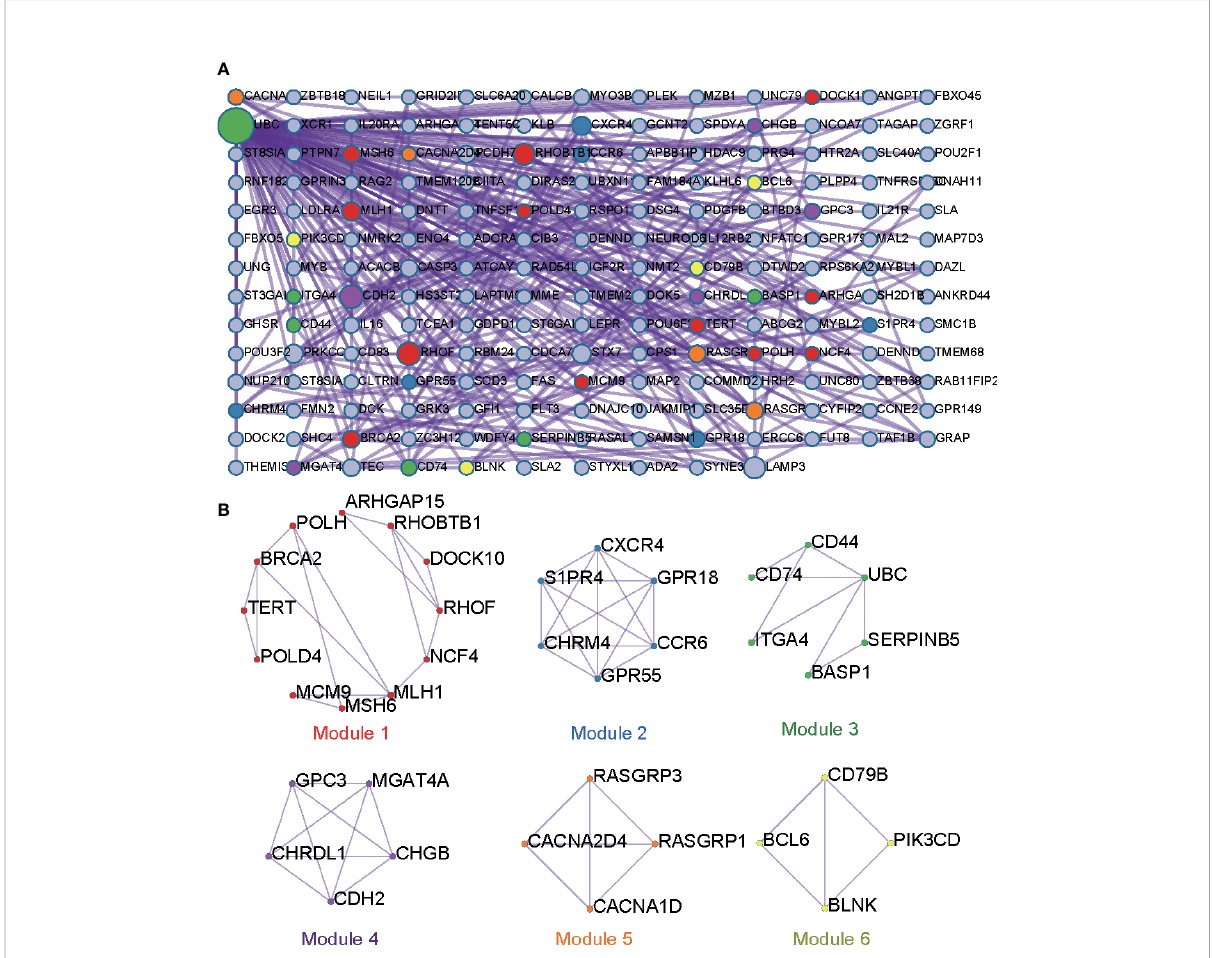
FIGURE 7 PPI interaction networks and core modules for DE genes in cluster 2. (A) . PPI interaction network. (B) . Modules of